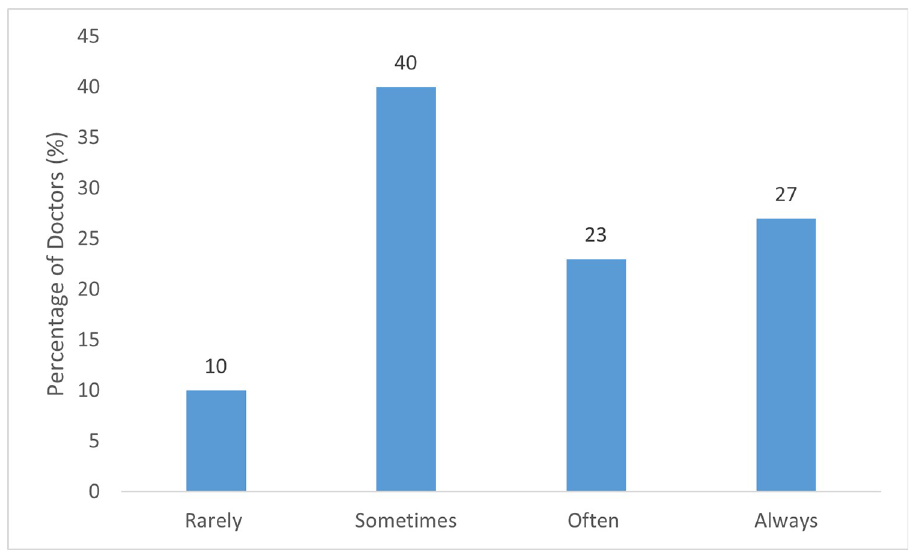
Fig 1. Frequency/percentage of doctors reporting return to work discussion in patient care planning.